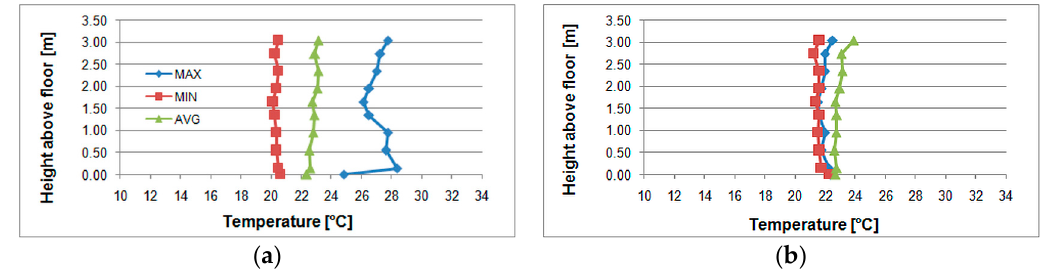
Figure 12. Vertical profile of the internal air temperature for the working hours: ( a ) during the whole measurement period; ( b ) during the transitional week.